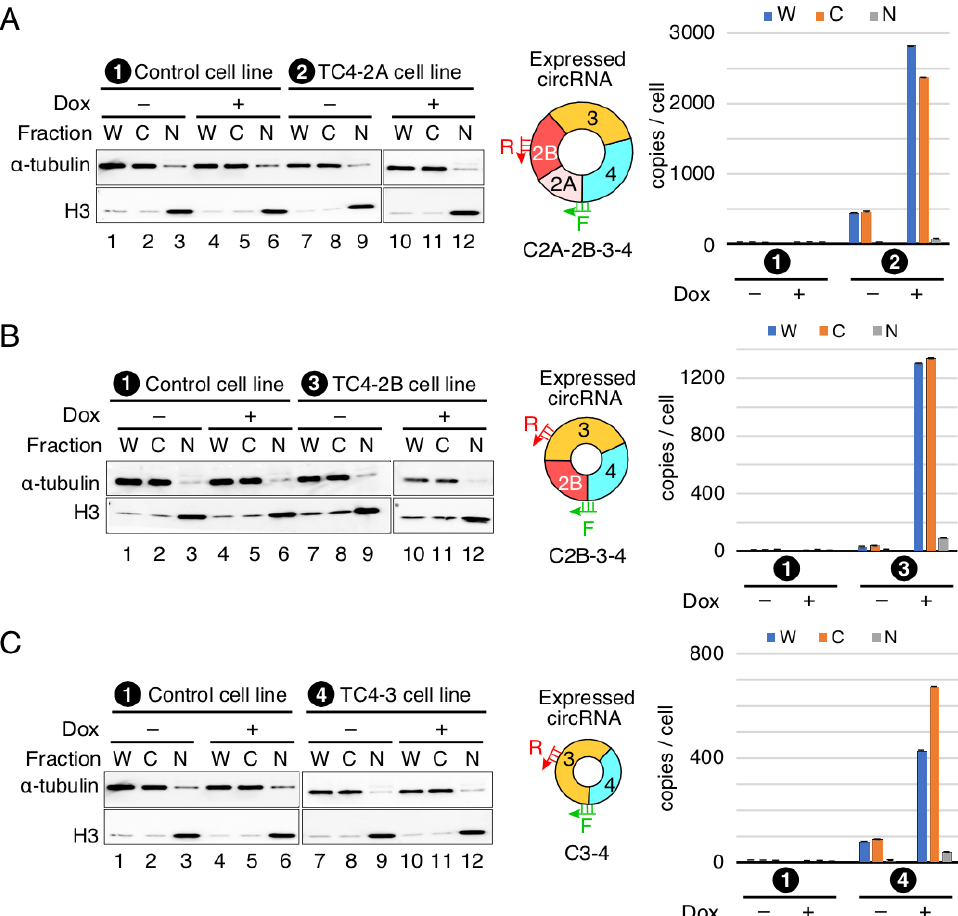
Figure 6. Cellular localization of SMN circRNAs. ( A ) Localization of C2A-2B-3-4. Left panel: diagrammatic representation of C2A-2B-3-4 expressed in TC4-2A stable cell line designated as (2). Middle panel: Western blot result showing the expression of α -tubulin and H3 in different cell fractions. Cell lines used are indicated at the top of the gels, with (+) and ( − ) signifying the presence and absence of Dox, respectively. Abbreviations: W, whole cell lysate; C, cytoplasmic fraction; N, nuclear fraction. Middle panel shows the type of circRNA overexpressed. Annealing positions of primers used for qPCR are shown. Right panel: bar diagram showing the copy number of C2A-2B-3-4 per cell, as determined by qPCR. Labeling of cell lines are same as in the left panel. ( B ) Localization of C2B-3-4. All the labeling is the same as in ( A ). ( C ) Localization of C3-4. All the labeling is the same as in ( A